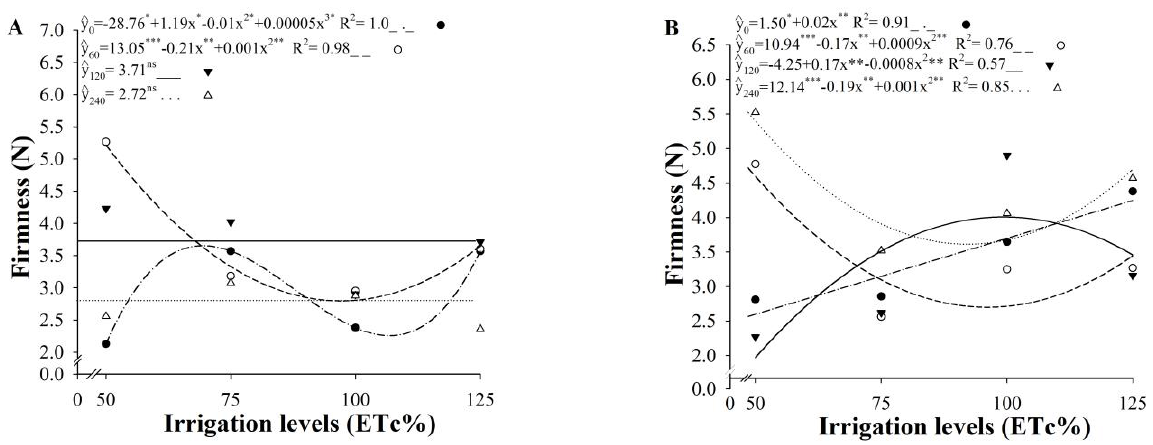
Figure 7. Firmness of fig fruits produced in the 2018/2019 ( A ) and 2019/2020 ( B ) crop years as a function of irrigation levels and potassium doses under semiarid conditions in the 2018/2019 and 2019/2020 crop years. * Significant ( p < 0.05); ** Significant ( p < 0.01); *** Significant ( p < 0.001); ns Not significant ( p > 0.05).